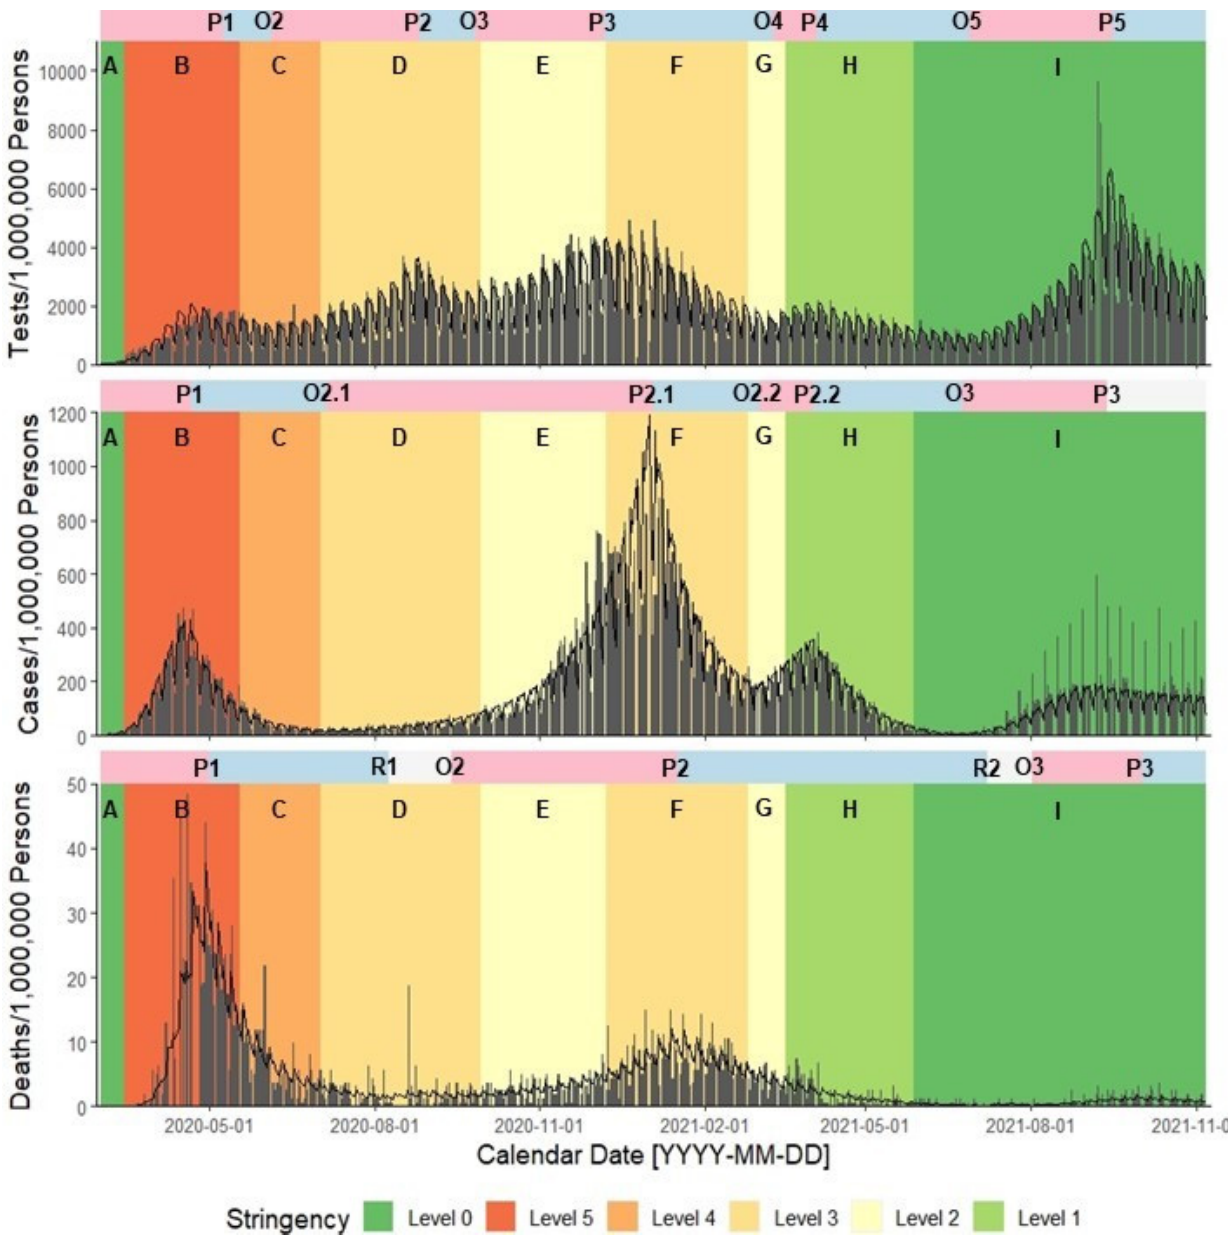
Figure 2. Multi-panel, shared-axis time series plots of MDPH-reported Massachusetts statewide tests (top panel) and JHU-reported Middlesex County cases and deaths (middle and bottom panels, respectively) by outbreak critical period and non-pharmaceutical intervention phase from 2 March 2020 through 7 November 2021. Within each plot, we provide estimated rates (grey bars) from reported data with fitted model results (black lines) from segmented negative binomial regression models adjusted for linear and quadratic trends for each outbreak critical period as defined by Kolmogorov-Zurbenko adaptive filters. Colored bars above each plot depict acceleration (pink), deceleration (blue), and steady-state (grey) periods as reported in Table 3 and Figure 1. We embedded text to signify the onset timing (O1–O5), peak timing (P1–P5), and resolution timing (R1–R2) of critical periods across outbreak waves. Background colors depict phases of Massachusetts non-pharmaceutical interventions from most stringent (red) to least stringent (dark green). We label each intervention phase in accordance with Table 1 (A–I). We report incidence as tests, cases, and deaths per 1,000,000 persons.